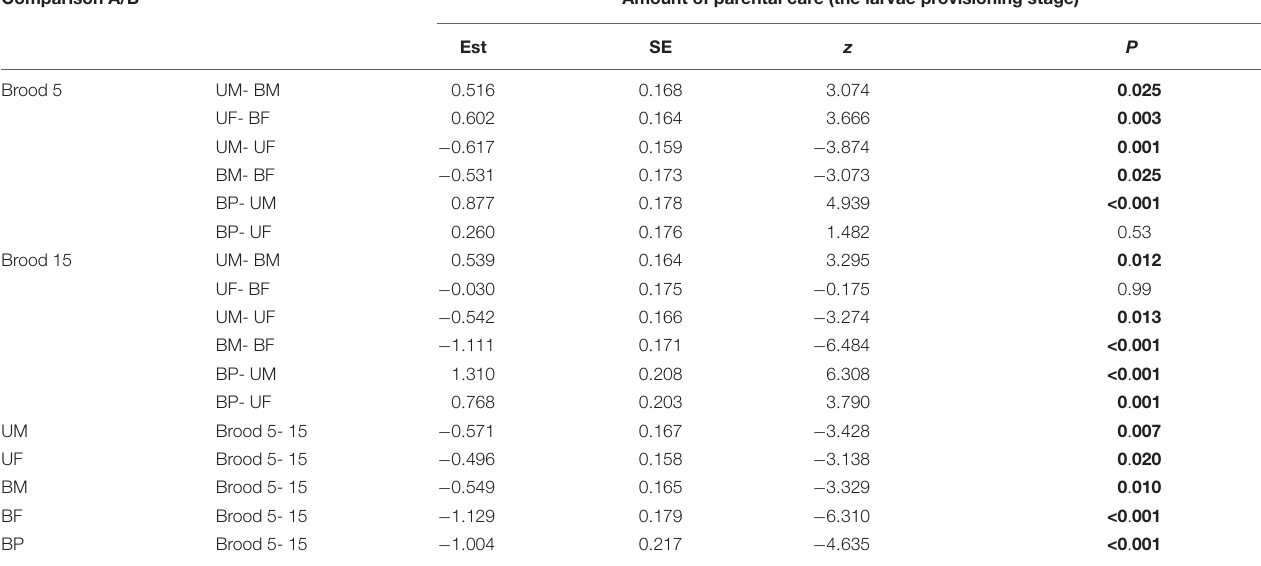
TABLE 4 | Pairwise comparisons (Tukey post hoc test) for the interaction of parental care system (A: uniparental male, uniparental female, biparental male, biparental female; B: uniparental male, uniparental female, biparental male and female combined) and brood size (5 vs. 15) on the amount of parental care during the larvae provisioning stage in the first